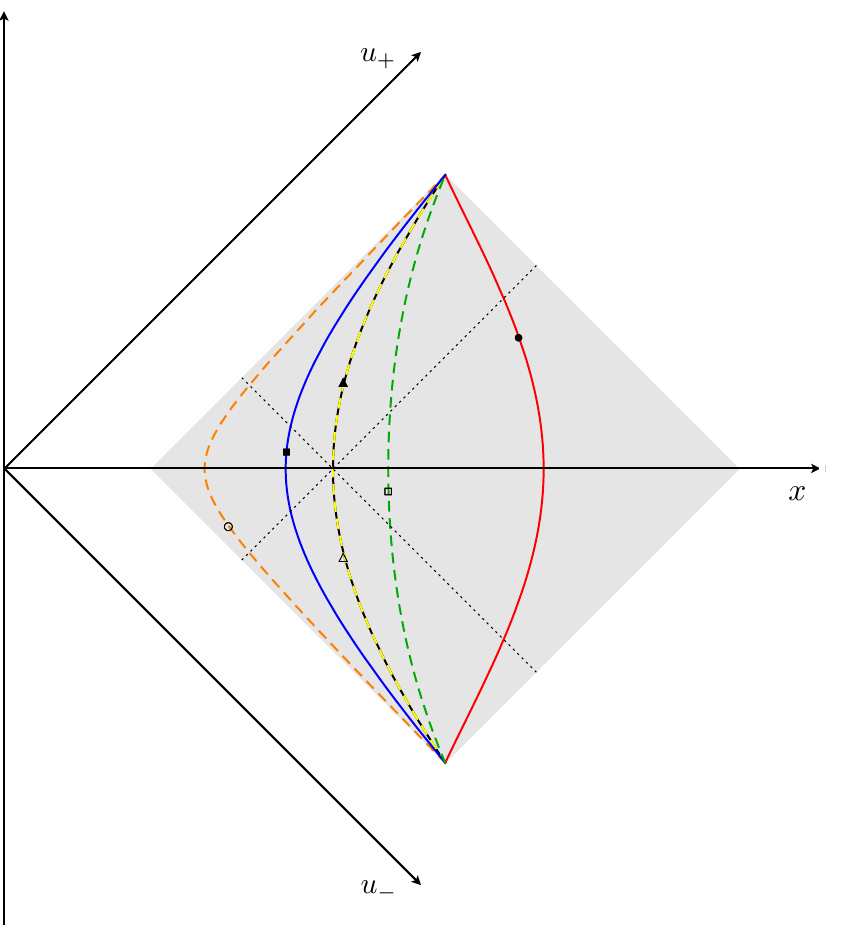
Figure 3 . Three pairs of modular trajectories. Each pair is made by conjugate trajectories whose initial points at τ = 0 are indicated through the same symbol (filled or